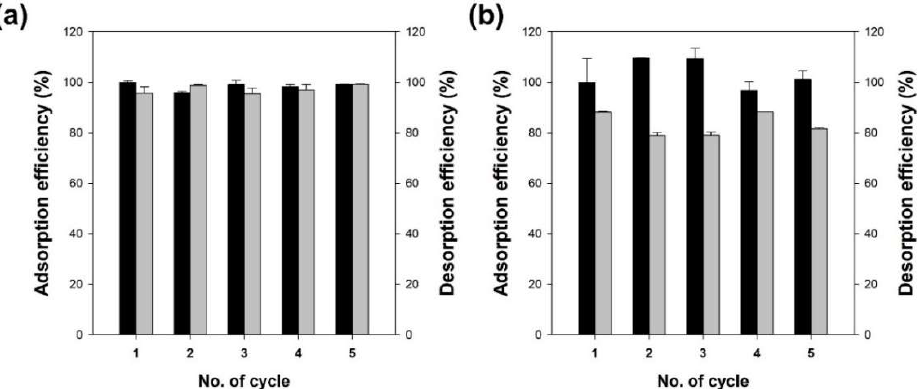
Figure 8. Adsorption capacities (black bars) and desorption efficiencies (gray bars) of alginate/biochar hydrogel beads (4% alginate/1% biochar) for Cu 2+ ( a ) and (4% alginate/4% biochar) for benzene ( b ).